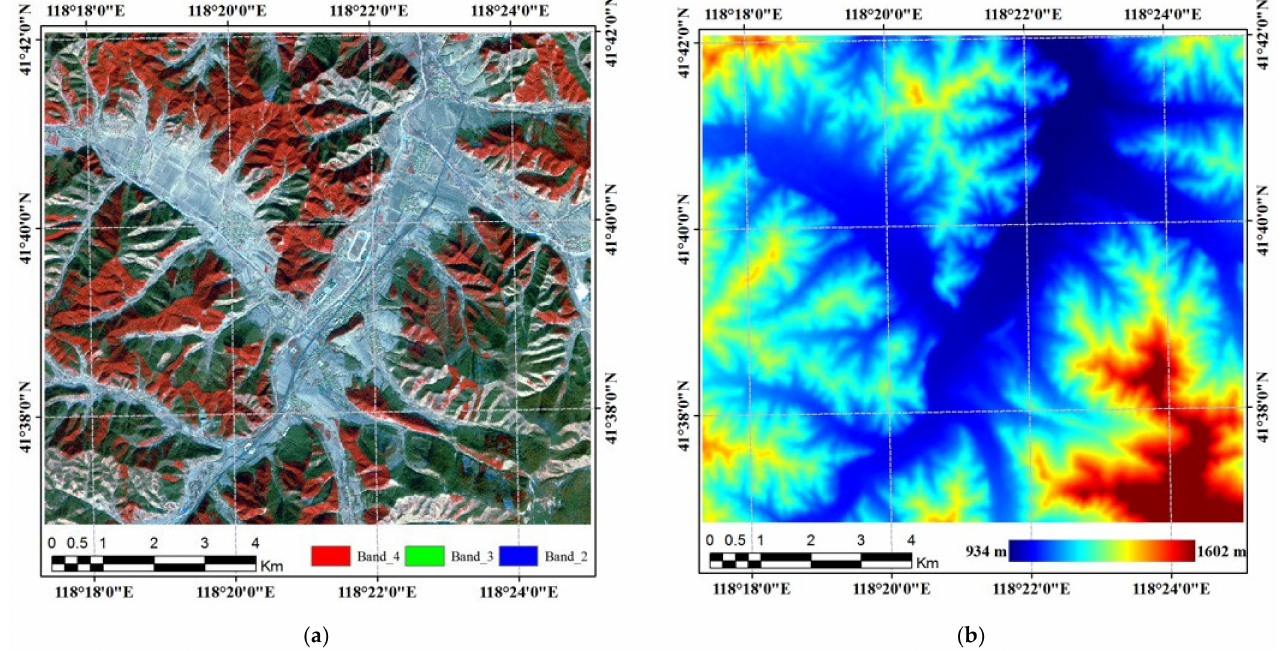
Figure 4. The optical satellite image and DEM data in the test area: ( a ) The false-color combinations image (Band_4: 0.77~0.89 µ m; Band_3: 0.45~0.52 µ m, Band_2: 0.52~0.59 µ m) acquired by the GaoFen- 2 satellite on 1 January 2019. The resolution of the fused image was 0.8 m. ( b ) The SRTM DEM data were resampled to 10 m